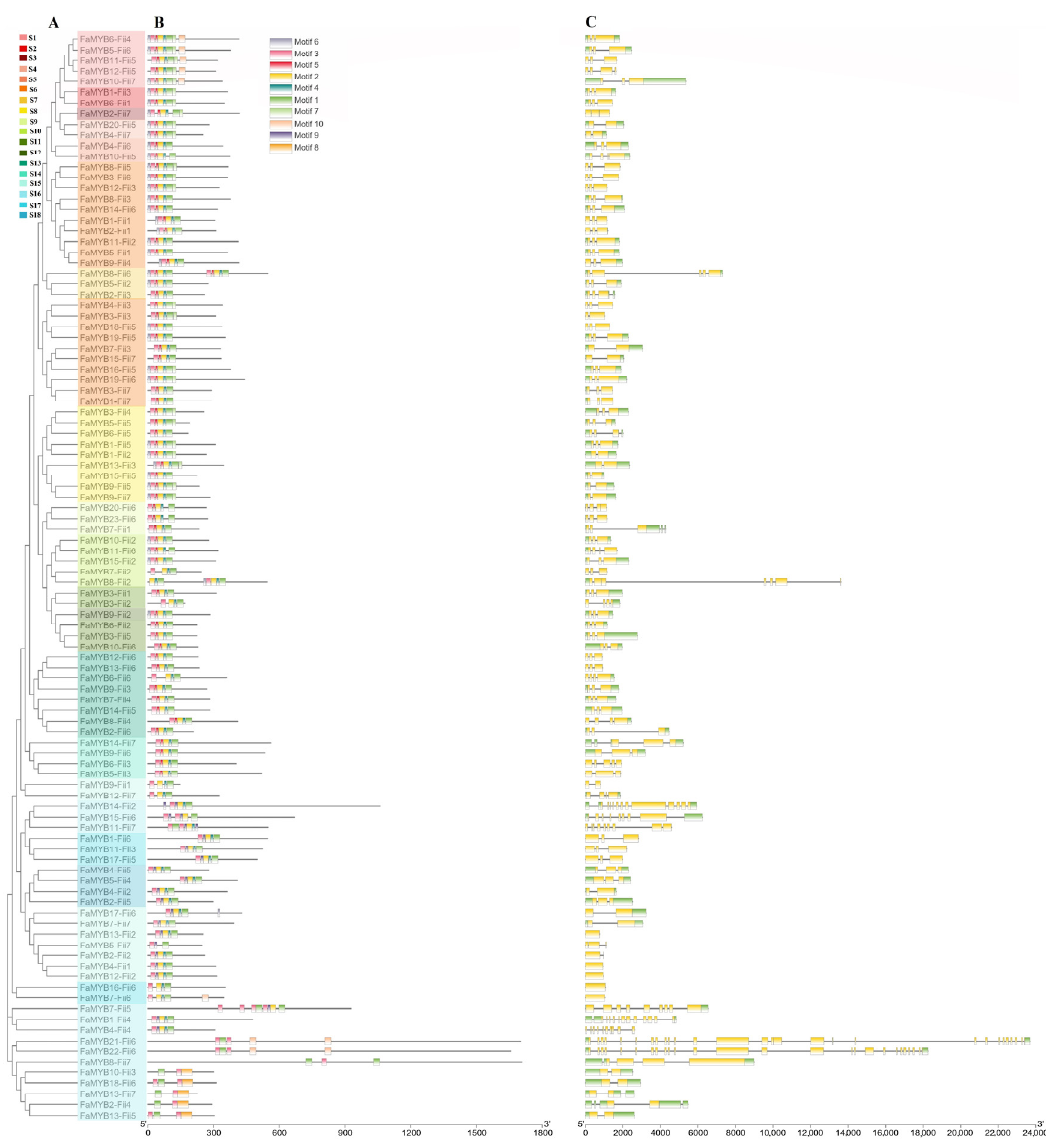
Figure 3. The NJ-tree ( A ), motifs ( B ) and gene structures ( C ) of MYBs of Fii subgenome ( FaMYB-Fiis ). Different groups of NJ-tree are colored, respectively. Top 10 conserved motifs are located on the amino acid residue scale plate of FaMYB-Fiis proteins. The introns (lines), exons of CDS (coding sequence) region in yellow and the UTR (untranslated region) in green are located on the nucleotide scale plate of genomic sequences.